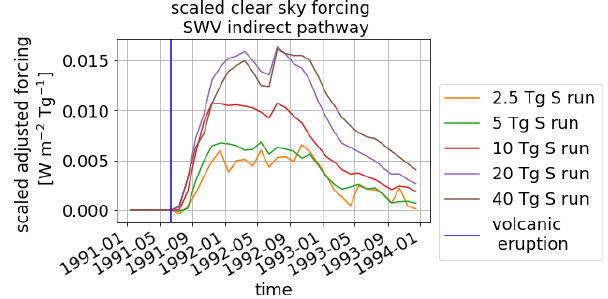
Figure A5. Scaled time evolution of the adjusted clear-sky SW forc- ing in the tropical region [− 5 , 5 ] ◦ latitude for all eruption strengths. The blue line marks the eruption time. All clear-sky forcings are di- vided by the mass of emitted sulfur. Incoming fluxes are defined as positive; outgoing fluxes are defined as negative.